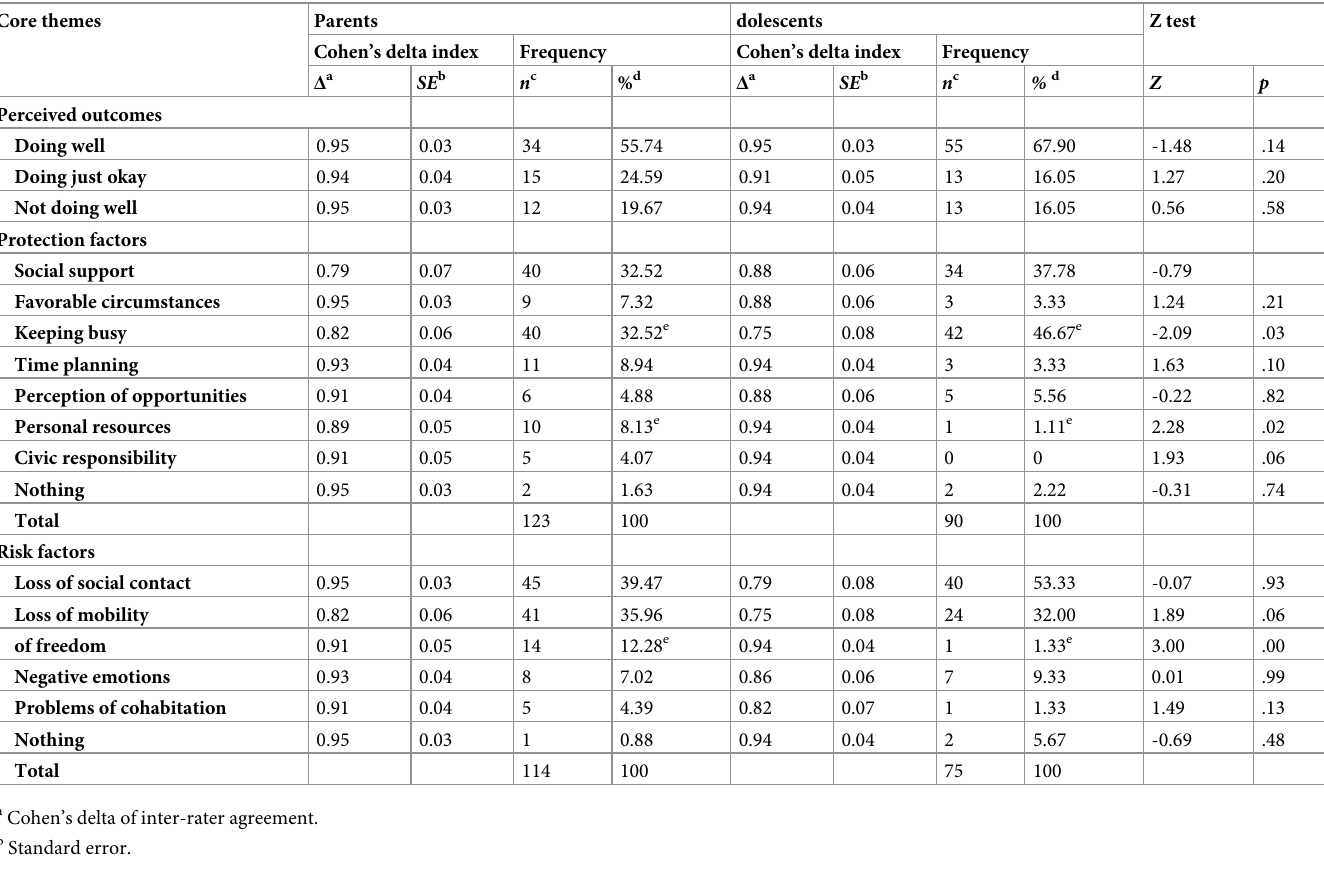
Table 1. Core themes for the study